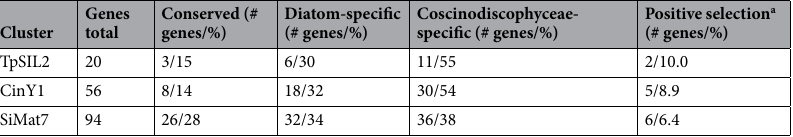
Table 1. Degree of conservation in selected gene clusters. a Present in a list of 809 candidates genes of positive selection 45